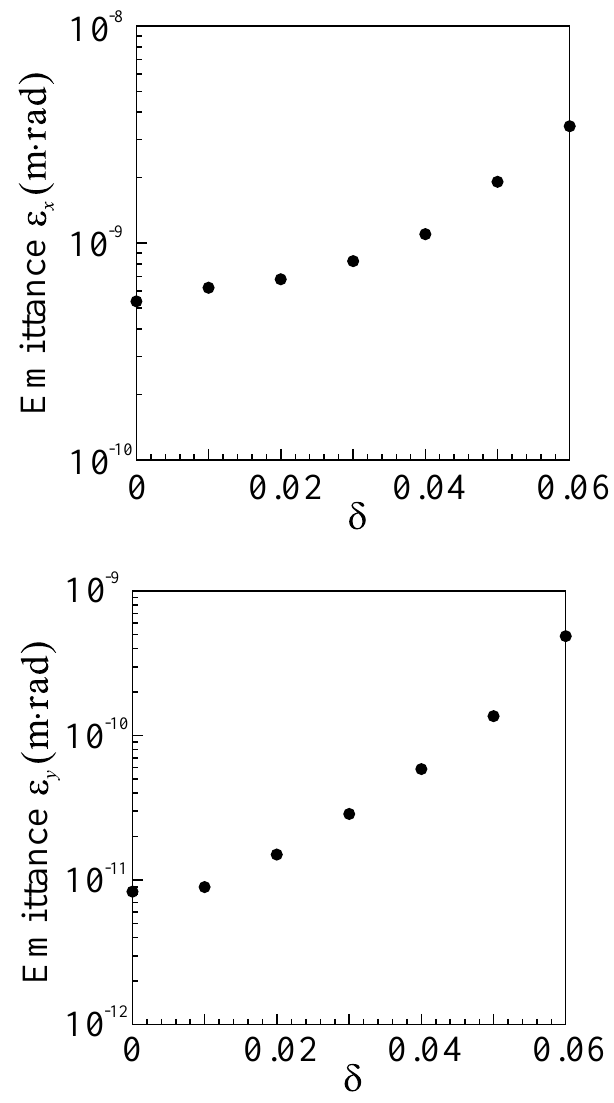
FIG. 12. Dependence of the emittances in the defocusing op- tics with chromaticity correction on the relative energy